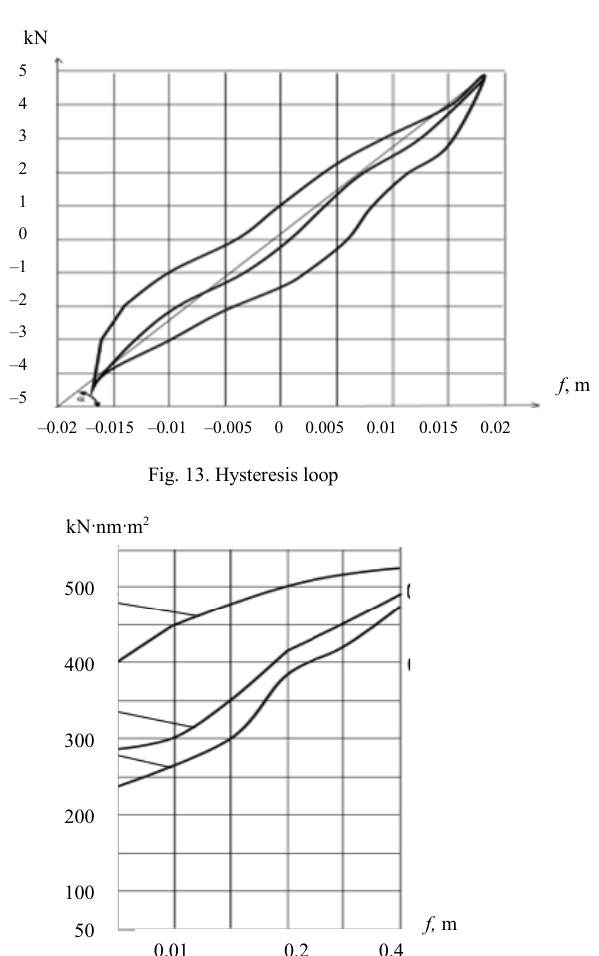
Fig. 14. Dependence of the damping coefficient of the suspension: 1) suspension without a recuperator; 2) with an unloaded recuperator; 3) with a loaded